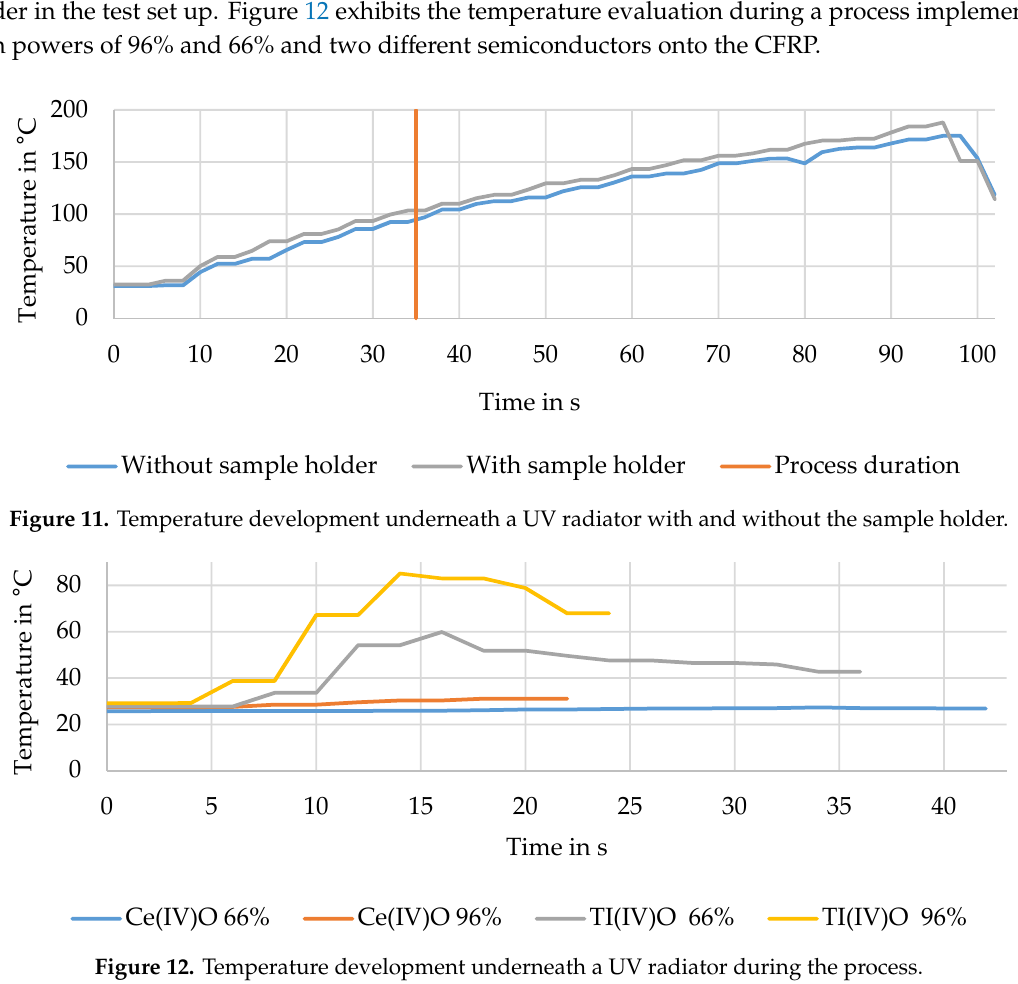
Figure 12. Temperature development underneath a UV radiator during the process.